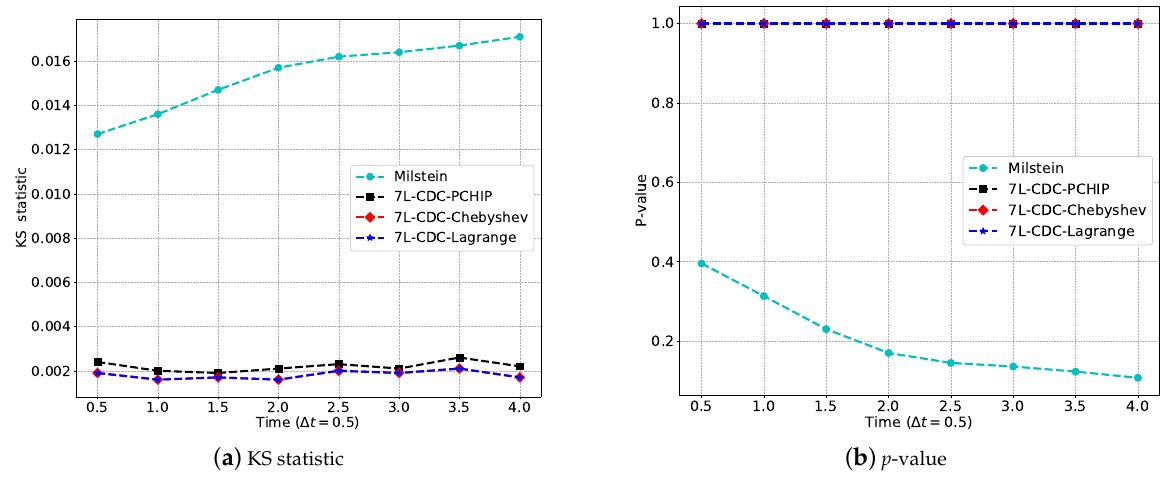
Figure 5. The Kolmogorov–Smirnov test: ∆ t = 0.5, µ = 0.1, σ = 0.3, Y 0 = 1.0, with 10,000 samples. When we have a small KS statistic or a large p -value, the hypothesis that the distributions of the two sets of random samples are the same can not be